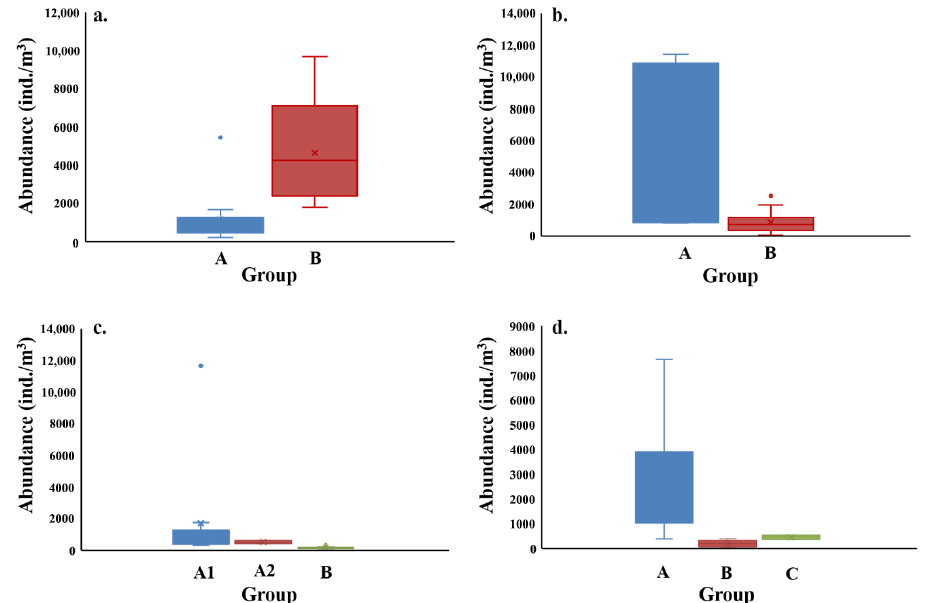
Figure 9 Figure 9. Seasonal differences in the copepod abundance between the station groups classified by the cluster analysis results: ( a ) spring, ( b ) summer, ( c ) fall, ( d ) winter. A, B, and C represent groups of stations distinguished based on species similarity. A1 and A2 are subgroups subdivided by species similarity within group A. The upper and lower bars in the bar graph represent the range of the maximum and minimum values (excluding the